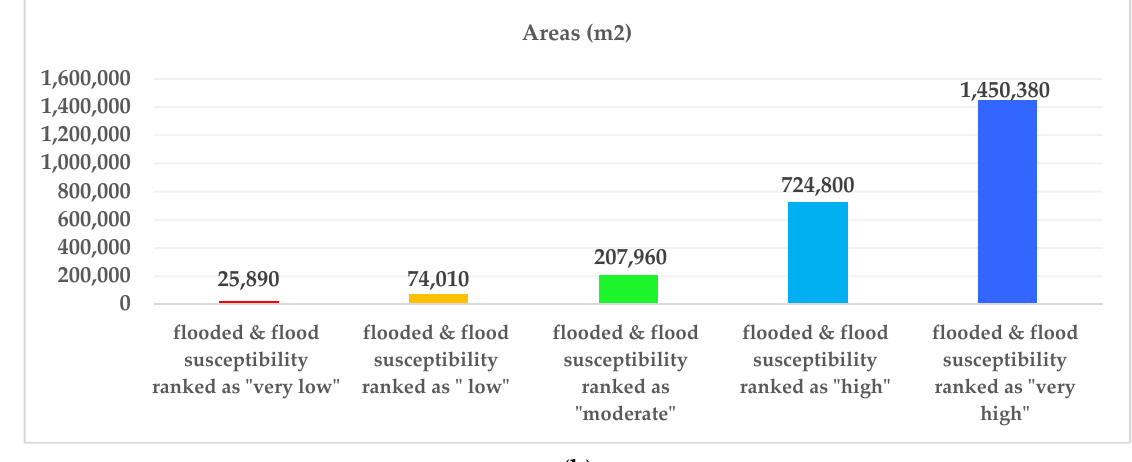
Figure 11. Comparison of flooded by hazard map and by flood susceptibility (PSO-DLNN) ranked by each class based on ( a ) number of pixels and ( b ) area (m 2 ).